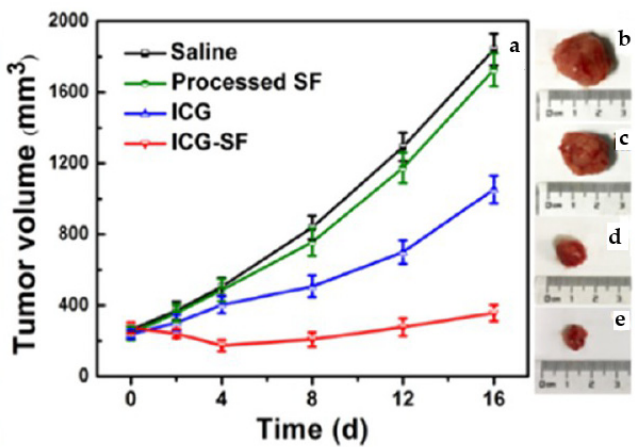
Figure 5. ( a ) Graphical representation of tumor volume vs. time in days after treatment of ICG-SF nanoparticles and corresponding pictures of excised tumors of mice treated with samples for 16 days, ( b ) saline, ( c ) SF nanoparticles, ( d ) ICG, and ( e ) ICG-SF nanoparticles. Reprinted with permission from [87] . Copyright © 2022, American Chemical Society.